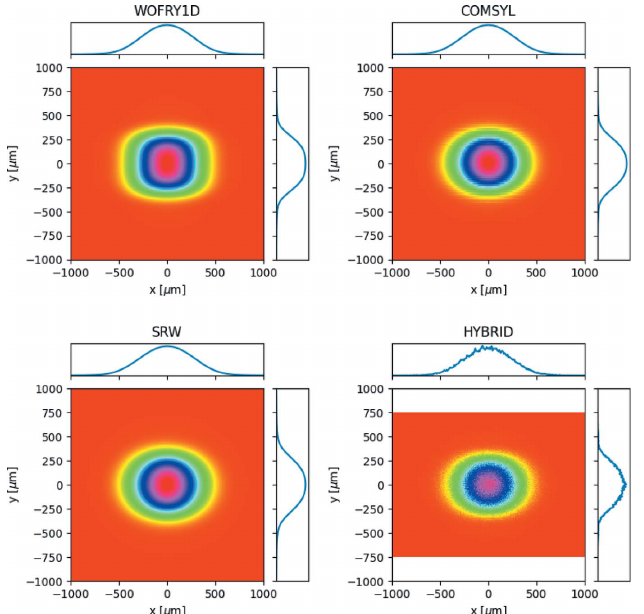
Figure 3 Spectral density at the slit plane (36 m from source) calculated by the four codes in use. The profiles correspond to the lines passing through (0, 0).